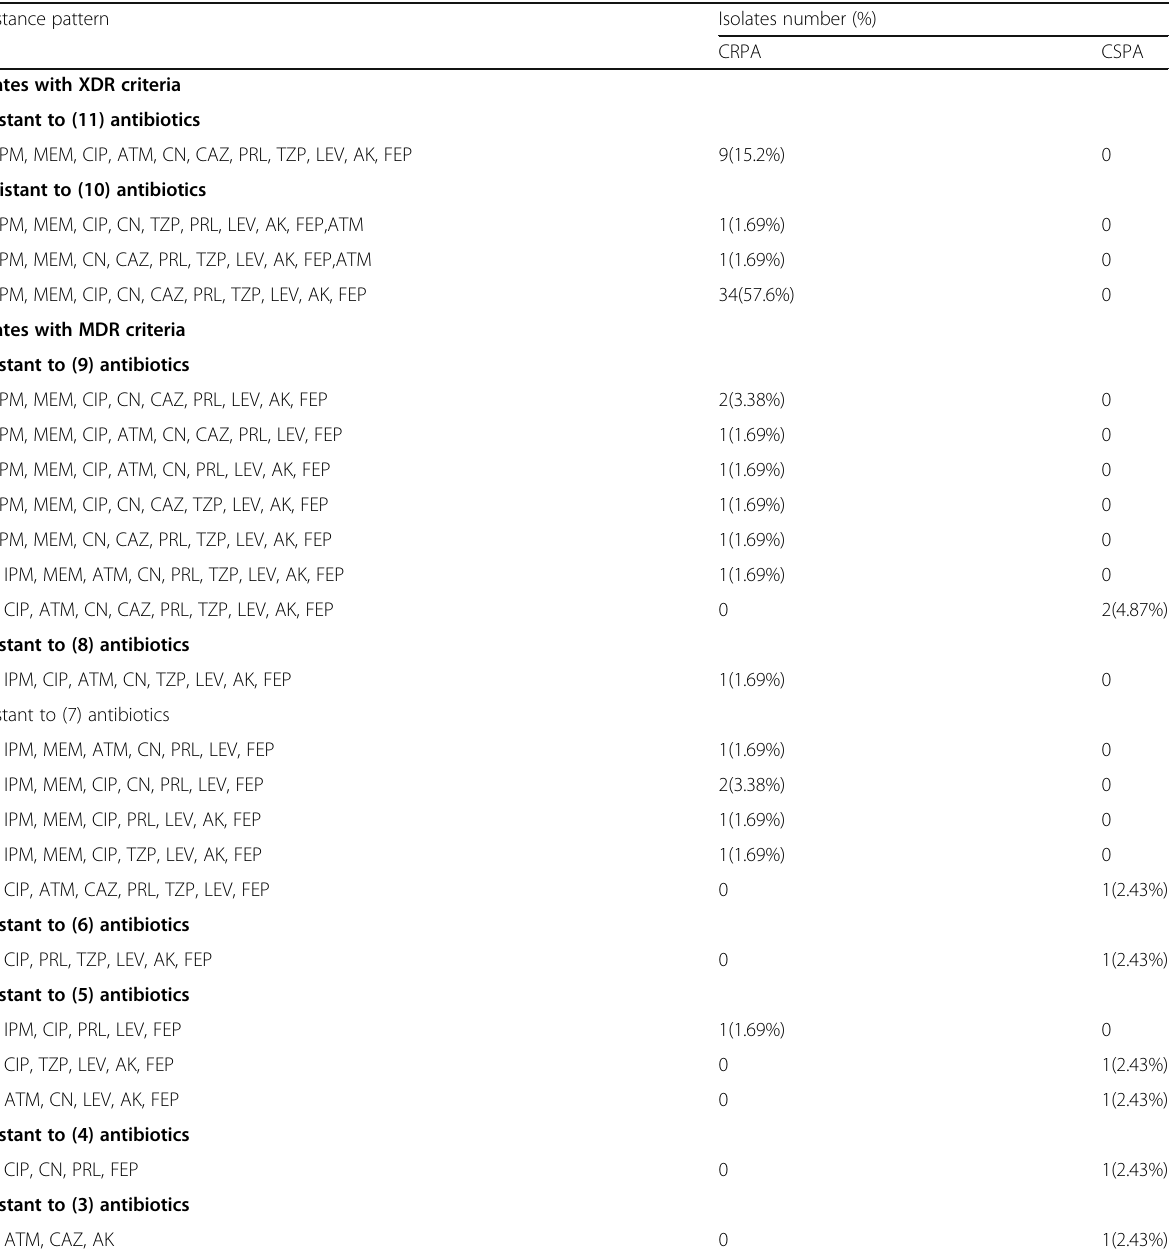
Table 3 Antibiotic resistance patterns of XDR and MDR P. aeruginosa isolates Resistance pattern